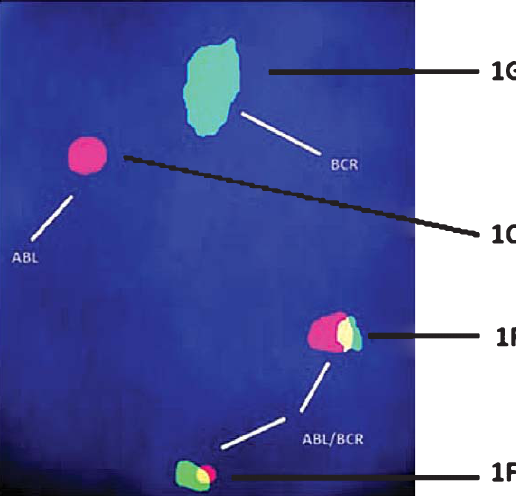
Fig. 2. FISH analysis using LSI BCR/ABL dual color, dual fusion probe set (Abbott Molecular Inc., Des Plaines, IL). A nucleus showing reciprocal translocation [t(9;22)] with ‘1O1G2F’ pattern. 1G: 1 green signal; 1O: 1 orange signal; 1F: 1 fusion signal showing both orange and green